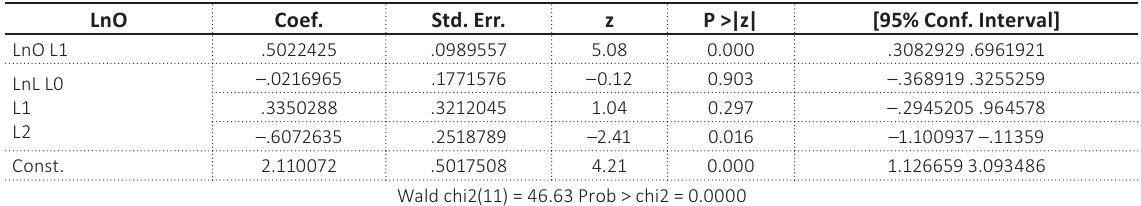
Table 1. Impact of changes in the share of homeowners with mortgage/housing loan on changes in the level of